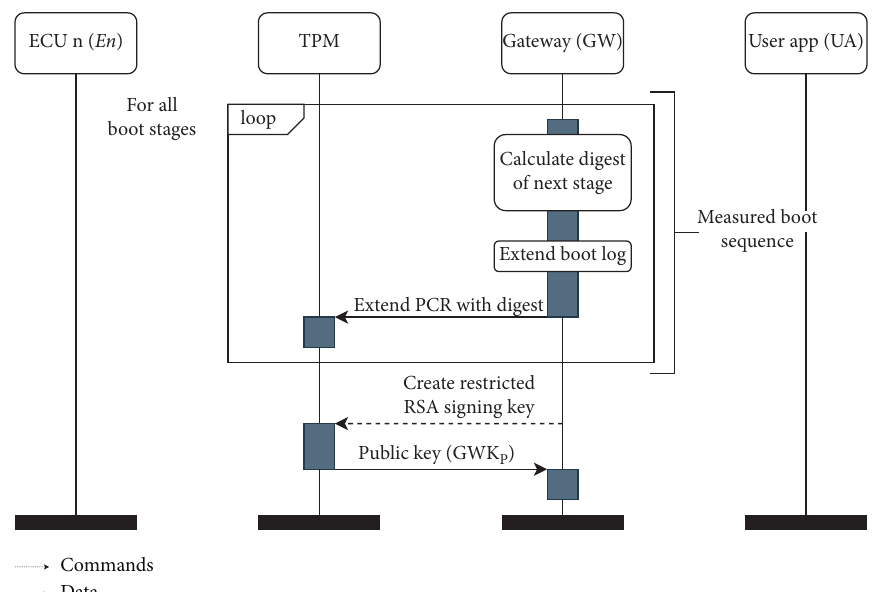
Figure 5: Message flow diagram of the starting sequence for the single